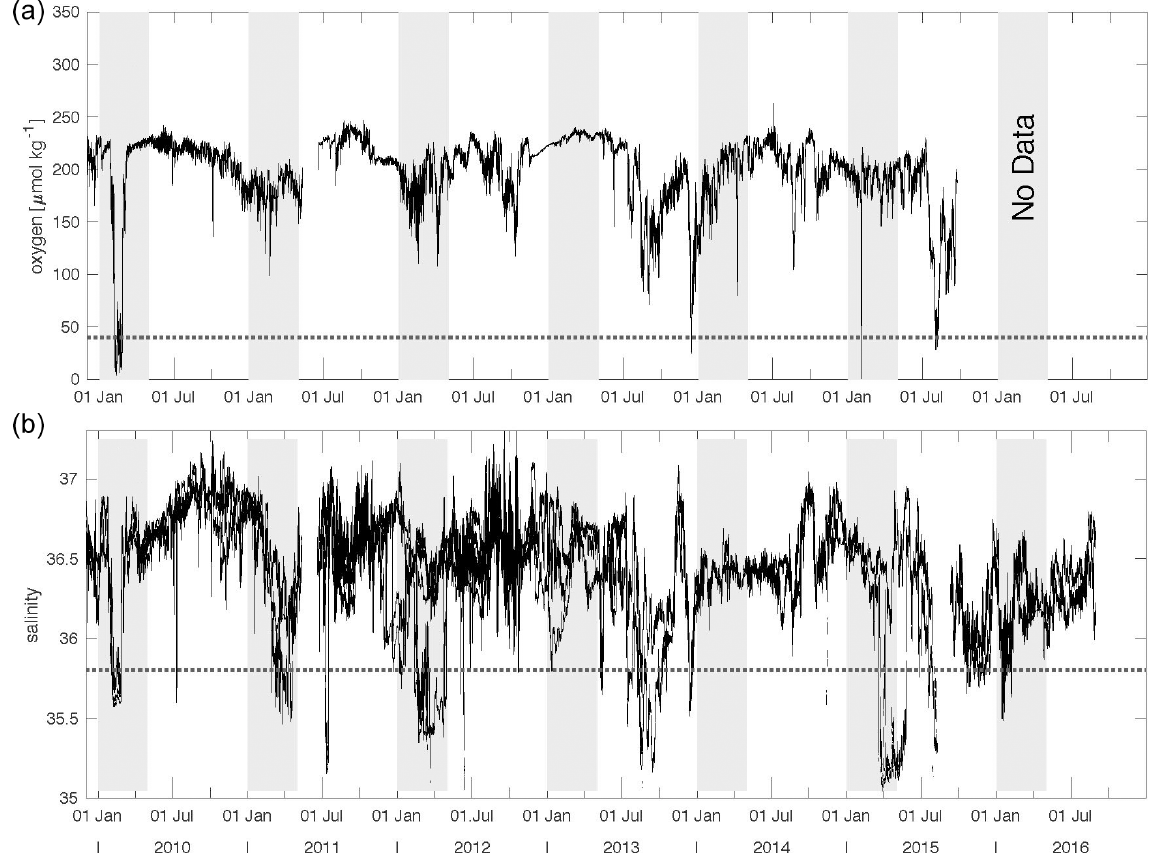
Figure 3. CVOO time series of 12h low-pass oxygen ( a , µmolkg − 1 ) and salinity ( b , using PSS-78). Dotted lines are considered thresholds that indicate the passage of low-oxygen eddies. Well-isolated eddies of coastal origin are assumed to correlate with low-salinity events and eventually may be paired with low oxygen concentrations. However, a statistically significant relationship between oxygen (based on one sensor) and salinity (based on four to six sensors; see Sects. 2.1 and 3.2) is not found. Grey-shaded areas indicate the periods January to April for reference. For instrument depths see